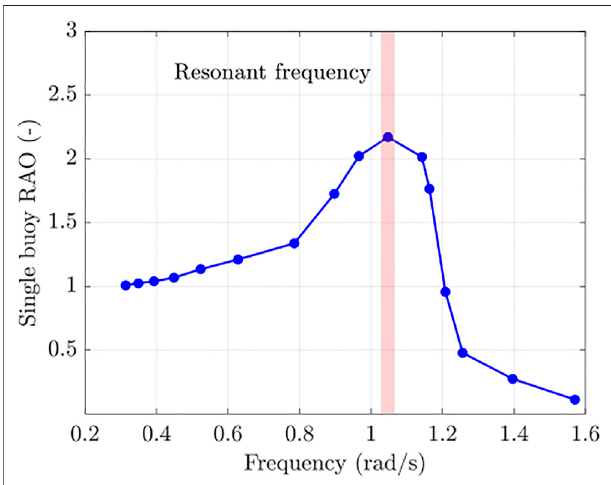
FIGURE 5 | Heave response amplitude operator (RAO) of the WECs.